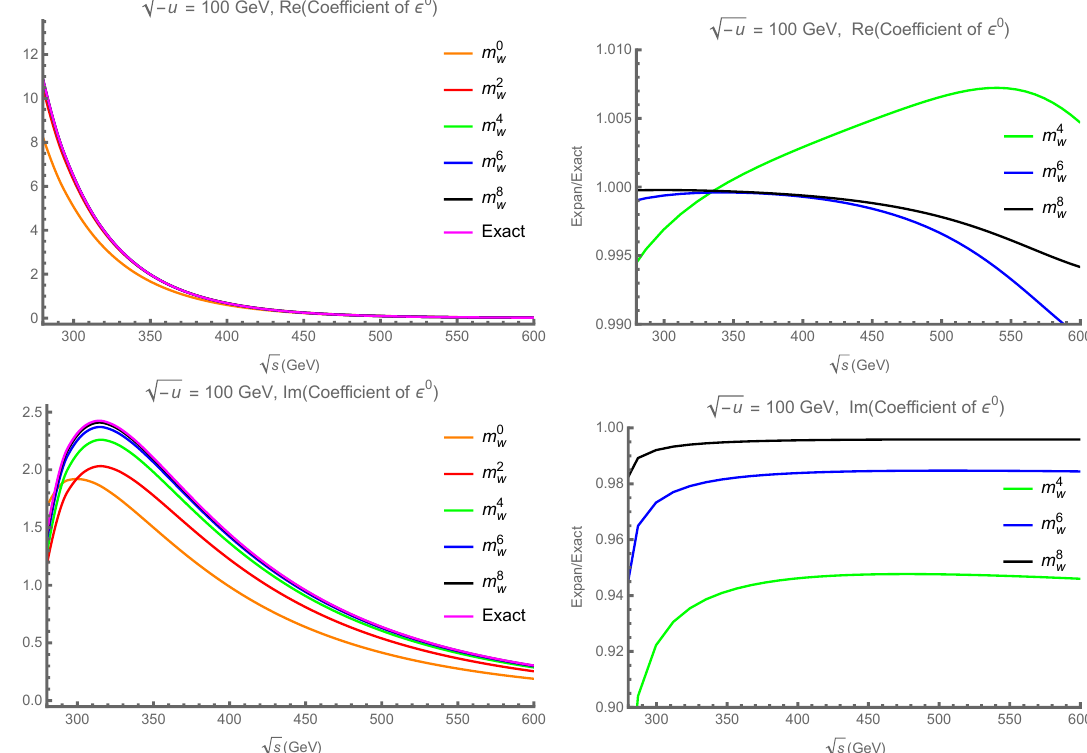
Figure 3. The real (upper plots) and imaginary (lower plots) parts of the (cid:15) 0 coefficient of (1 /m 6 ) I NP2 ( m 2 ) as a function of t 1 , 1 , 1 , 1 , 1 , 1 , 1 , 0 , 0 W